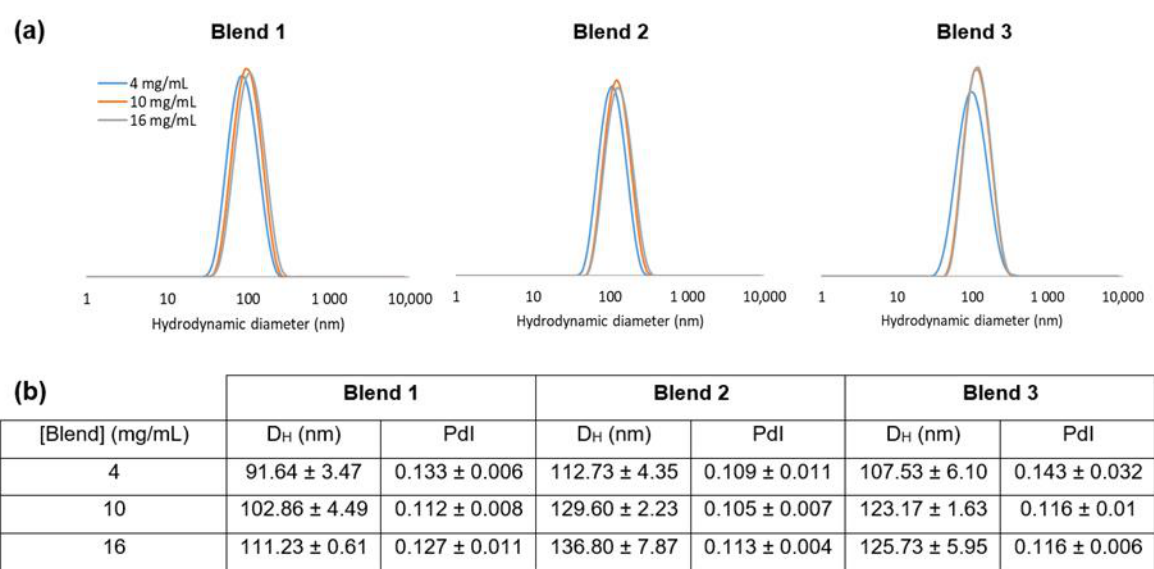
Figure 4. Characteristics of Nile red-labeled nanocarriers: ( a ) hydrodynamic diameter (D H ) distribu- tion plots; ( b ) associated values of hydrodynamic diameter (D H ) and polydispersity index (PdI).